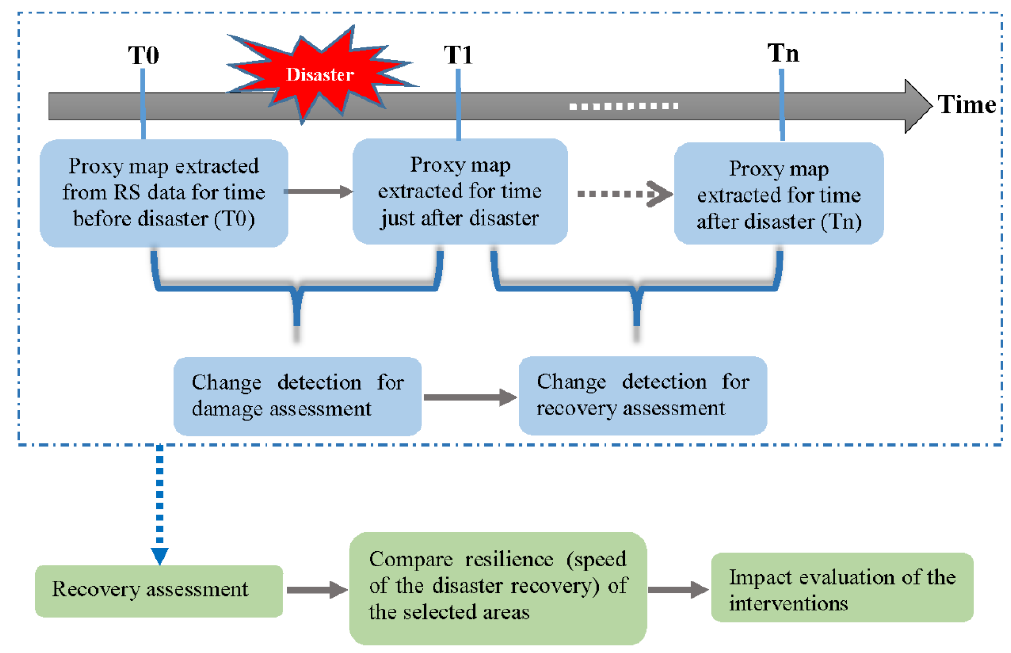
Figure 1. The conceptual framework connecting post-disaster recovery assessment using remote sensing-based proxies with impact evaluation.